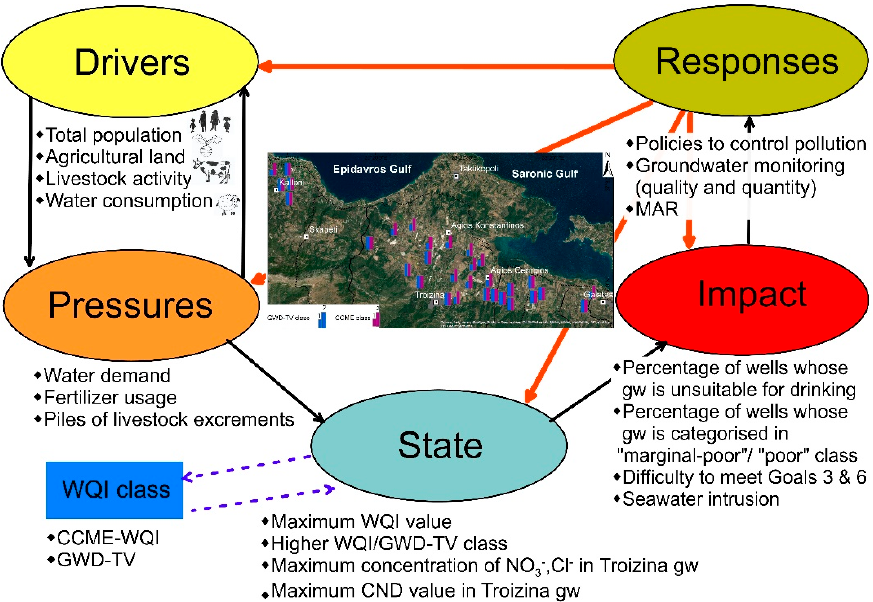
Figure 3. The DPSIR and WQI framework adopted in the investigation of achievement SDGs for groundwater resources of the area studied (MAR: Managed Aquifer Recharge, gw: groundwater). groundwater resources of the area studied (MAR: Managed Aquifer Recharge, gw: